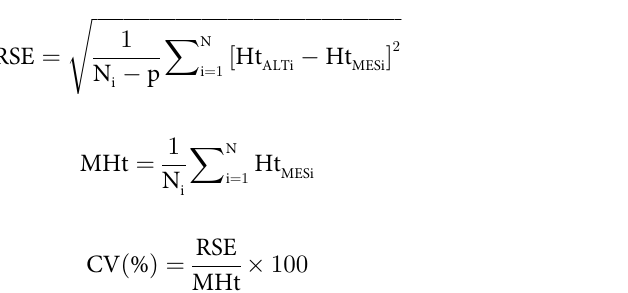
a and b are the parameters to be estimated; DBH is diameter at breast height measured at 1.30 m from ground